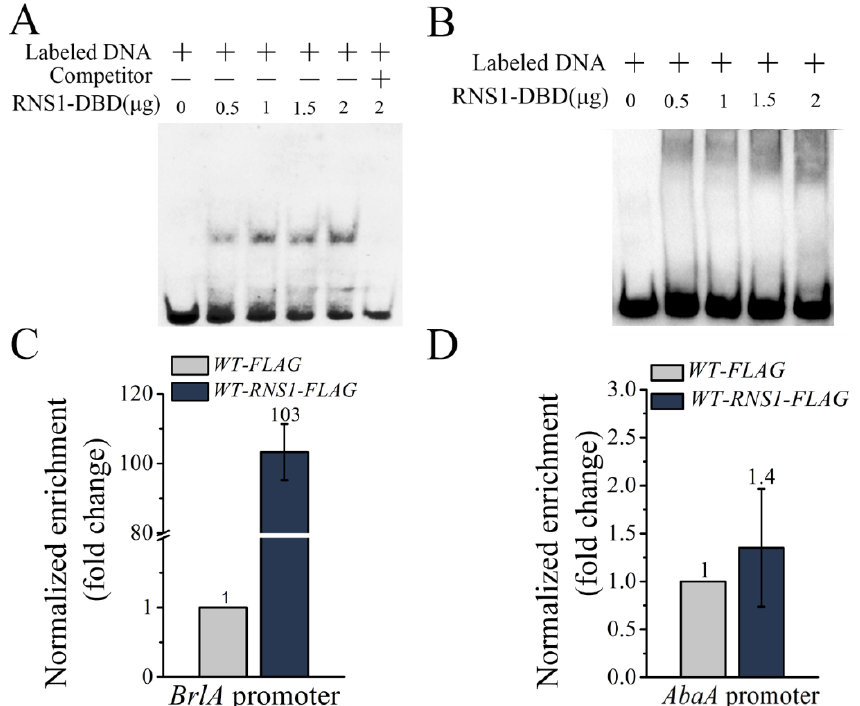
Figure 2. EMSA and ChIP-qPCR analysis of the binding of RNS1 to the putative the BM2 motifs in the promoters of the gene BrlA and AbaA . ( A ) EMSA analysis of the binding of the recombinant protein RNS1-DBD (the DNA binding domain in RNS1) to the Biotin-labeled BM2 motif in the BrlA promoter, and ( B ) in the AbaA promoter. The binding activity was demonstrated by the shift of the labeled DNA band prior to the addition of the specific competitor (the unlabeled DNA probe) in a 200-fold excess. ( C ) ChIP-qPCR analysis of the binding of the fusion proteins RNS1::FLAG to the BrlA promoter, and ( D ) to the AbaA promoter. WT-FLAG: a strain expressing the tag FLAG in the WT strain; WT-RNS1- FLAG: a strain expressing the fusion protein RNS1::FLAG protein in the WT .